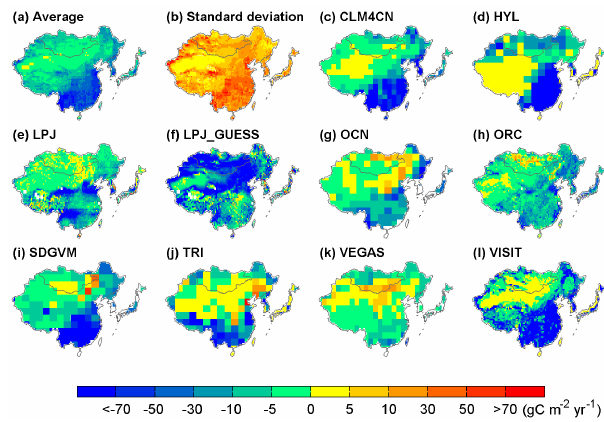
Fig. 5. Ten ecosystem models simulated spatial patterns of net ecosystem carbon balance in response to climate change and ris- ing atmospheric CO 2 (Simulation S2) during the period 1990–2009. (a) Average net ecosystem carbon balance from the ten models, (b) standard deviation of the ten model-derived net ecosystem carbon balance, and (c – h) net ecosystem carbon balance estimated by each model. Negative value indicates net carbon